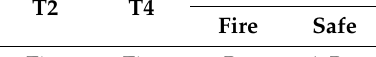
Figure 8. Application of Bayesian network (BN) to modelling fire domino effect in the terminal. ( a ) The domino effect starts from T1. ( b ) The domino effect starts from T1 and T5. Table 4. Conditional probability table of T5 in Figure